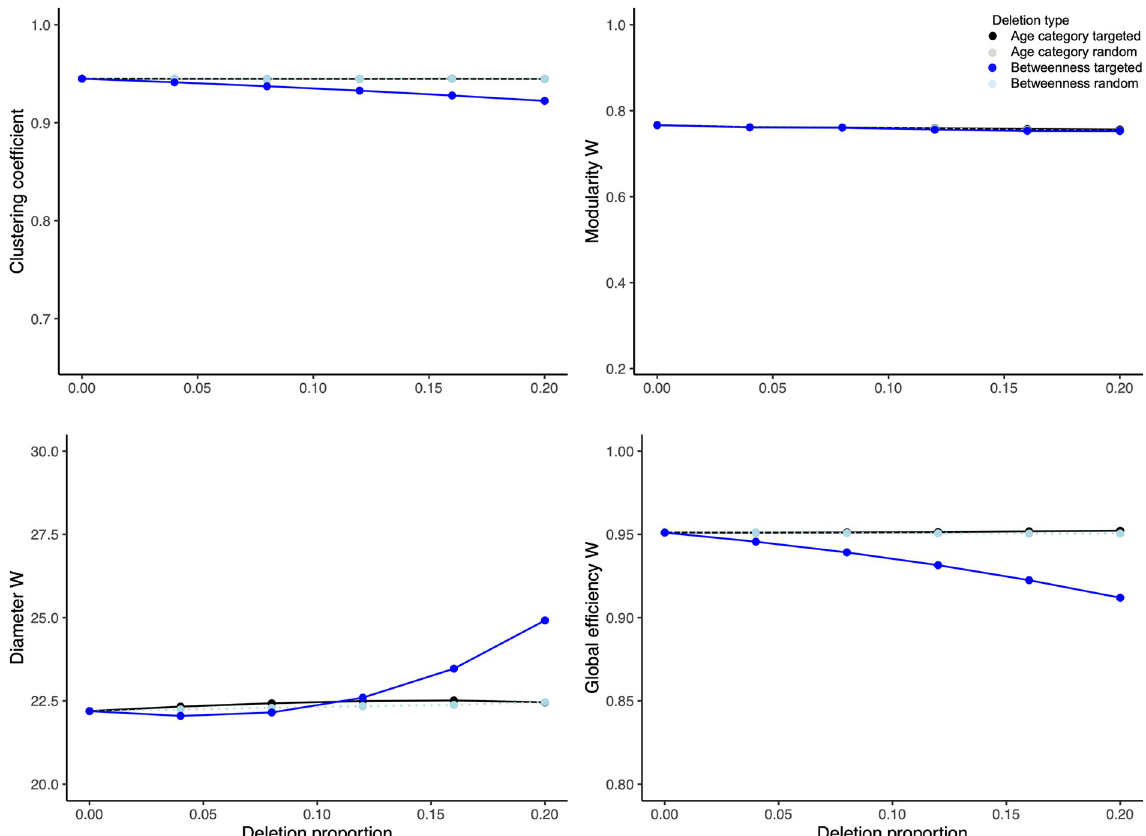
Fig 4. Graphs representing results (mean plus 95% confidence interval) of 100 deletions per each combination of deletion proportion (i.e., 0–20%) and type (i.e., random vs. targeted) in the empirically based network. The deletions were either targeted according to age category (black series) or betweenness centrality (blue series); or were random (grey and teal series represent random deletions without considering individual traits conducted as control conditions to age- or betweenness centrality-targeted experiments, respectively). The network indices evaluated included clustering coefficient as well as weighted modularity, diameter and global efficiency. For a cross-species context, the minima of y-axis ranges per clustering coefficient as well as weighted modularity and global efficiency are plotted to express the minima from a similar, theoretical treatment in an egalitarian primate society [46]. The weighted diameter index depends on group size, thus the pertinent y-axis is not expressed in a cross-species context. For results of Hedge’s g test expressing the difference in the effect size between the means of each network index between targeted versus random deletions along the deletion proportion axis and per deletion type, refer to S2 Table.